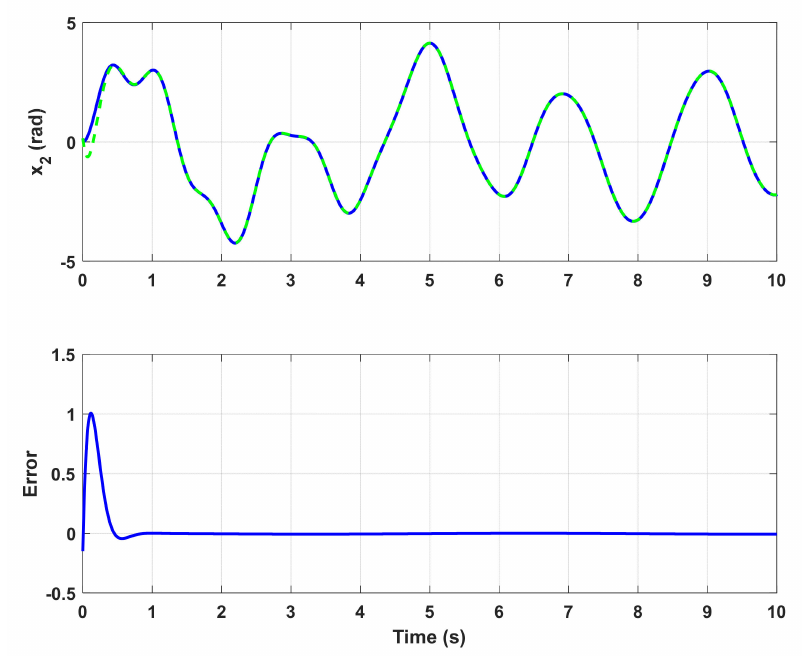
Figure 6. Estimation and error of driver gear